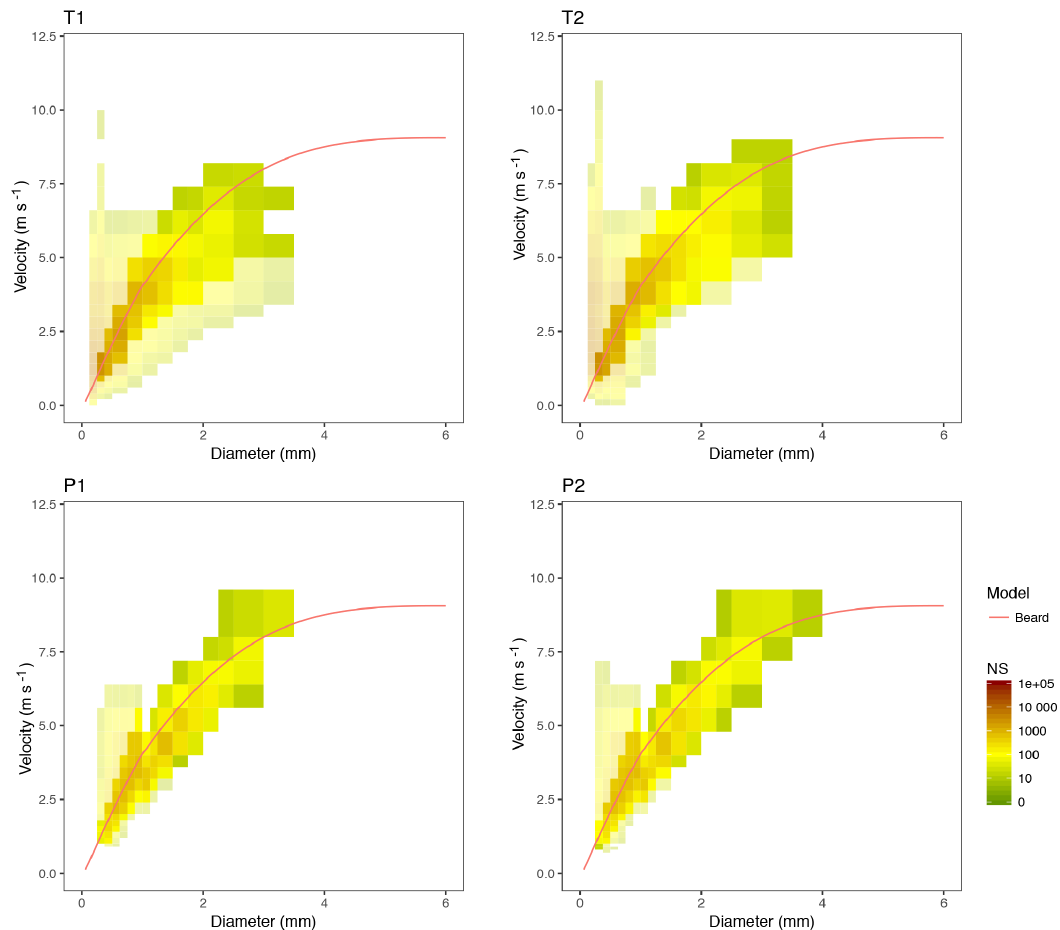
Figure 6. Particle size and velocity density (PSVD) plots of a low-intensity event (E455, 23 February 2015). Legend as in Fig.